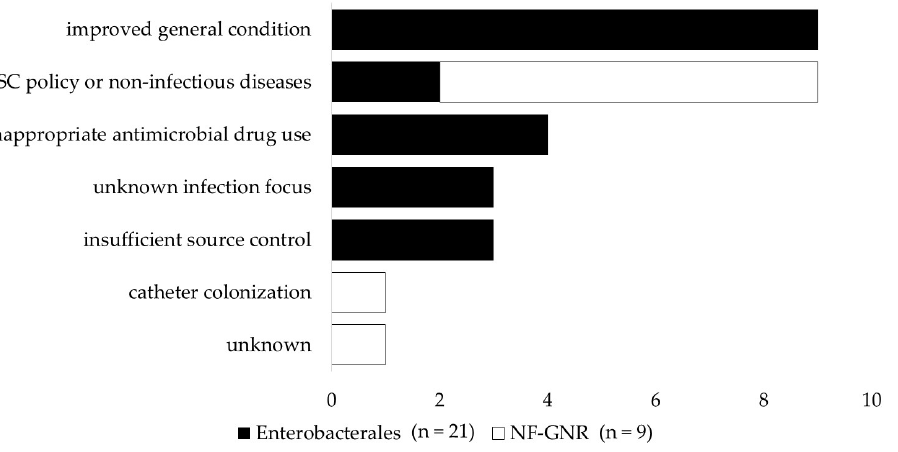
Figure 1. Reasons for non-clearance of persistent gram-negative bacteremia. An improved general condition means that a negative blood culture was not confirmed owing to an improved general condition. The underlying diseases among patients in line with the best supportive care policy were gastric cancer and graft-versus-host disease. A non-infectious disease is a case in which the clearance of persistent bacteremia could not be confirmed due to the death of the patient from a disease other than an infectious disease, extensive burn injury, cerebral infarction, acute renal failure, liver failure, and pancreatic cancer. Antimicrobial therapy was considered inappropriate when at least one of the following conditions was met: administration of ineffective antimicrobial agents, i.e., agents that did not effectively treat infections with organisms identified in the blood culture; continuation of the initial antimicrobial agents even though the result of the susceptibility test was known and de-escalation was possible; and administration of antibiotic therapy for a shorter time than the current medical standards. NF-GNR, glucose non-fermentative gram-negative rod.